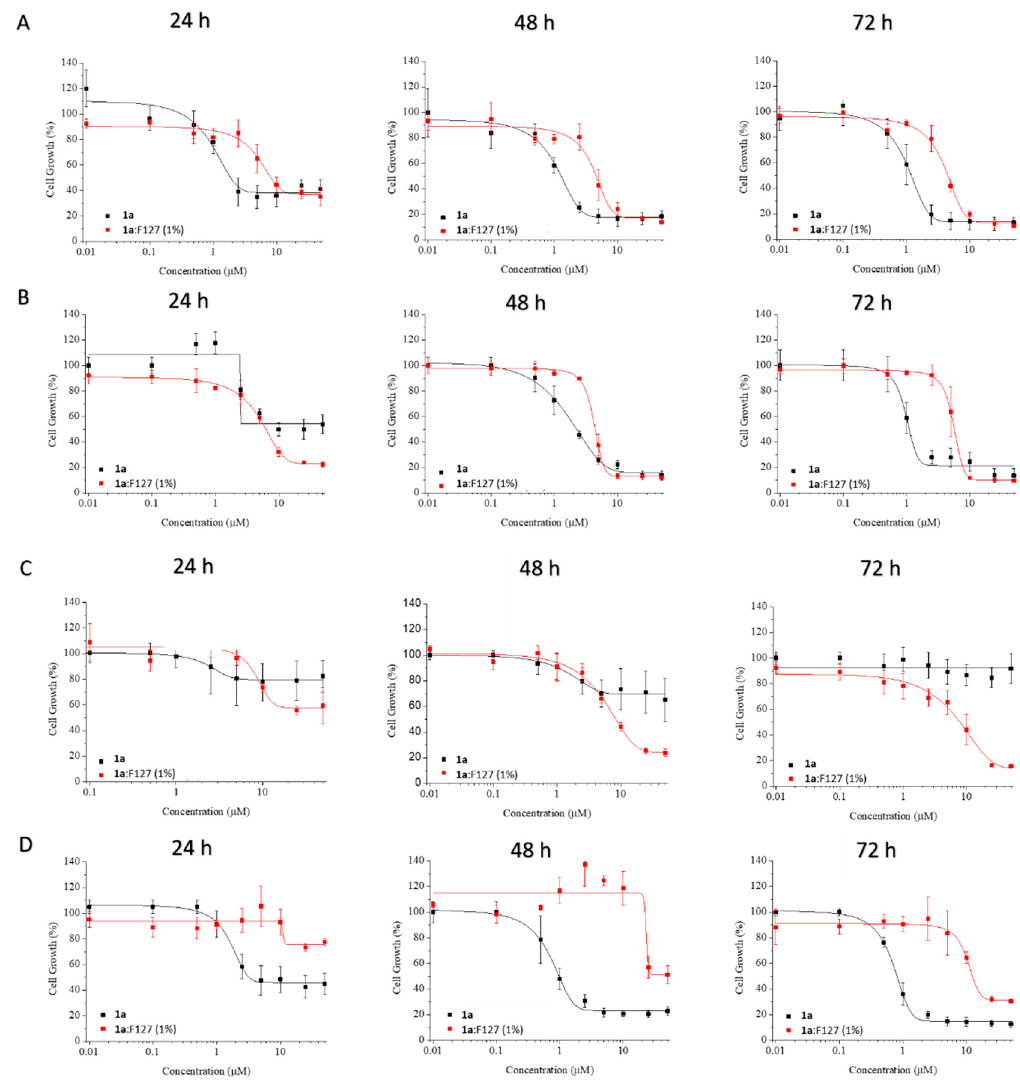
Figure 11. Dose-response curves obtained for 1a (black lines) and 1a :F127 (red lines), on HT-29 ( A ), HCT-116 ( B ), RKO ( C ) and Caco-2 ( D ) cells at 24, 48 and 72 h.